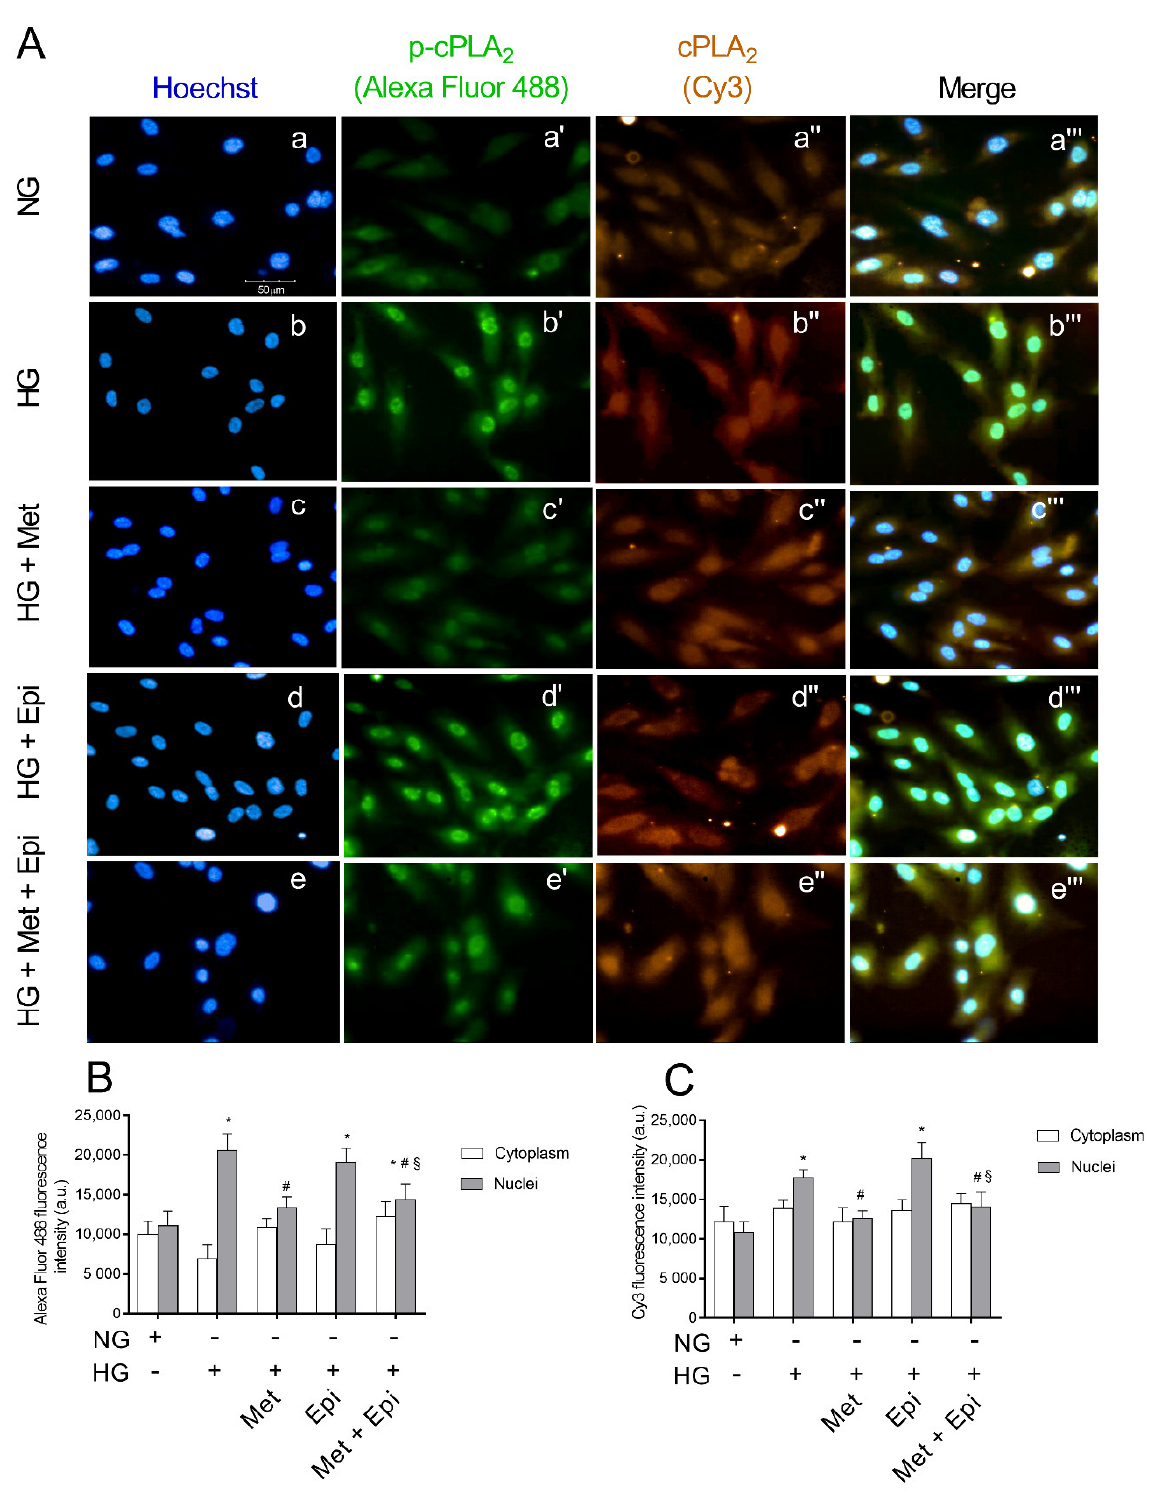
Figure 4. The effects of metoprolol and epinephrine on the nuclear translocation of cPLA 2 as assessed by immunocytochemistry in HREC that was treated with HG. ( A ) Representative images of immunocytochemical staining for phospho-cPLA 2 (p-cPLA 2 ) and total cPLA 2 (cPLA 2 ) in HREC. In presence of normal glucose, Hoechst-stained cell nuclei (a), p-cPLA 2 green fluorescence (a’), cPLA 2 red fluorescence (a’’) and merged pictures (a’’’). In presence of high glucose, Hoechst-stained cell nuclei (b), p-cPLA 2 green fluorescence (b’), cPLA 2 red fluorescence (b’’) and merged pictures (b’’’).